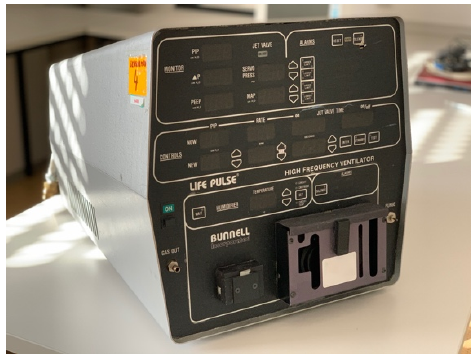
Figure 2. Neonatal jet ventilator—Life Pulse (photo by author).